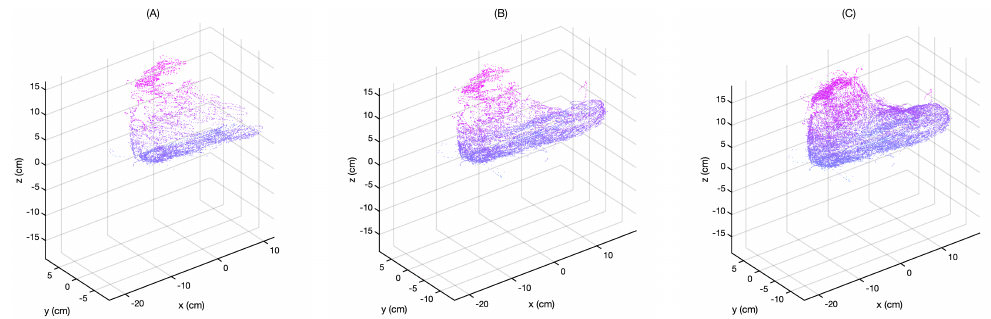
Figure 7. Build–up of visualization as the number of points increases from 0 to 10,000 ( A ), to 20,000 ( B ), and to 30,000 ( C ) at an angular resolution of 1 ◦ . The removal of points that do not lie on the surface is particularly notable on the bridge of the foot. In ( A ), the bridge consists of points that do not lie on the surface, while in ( B , C ) the bridge surface is better